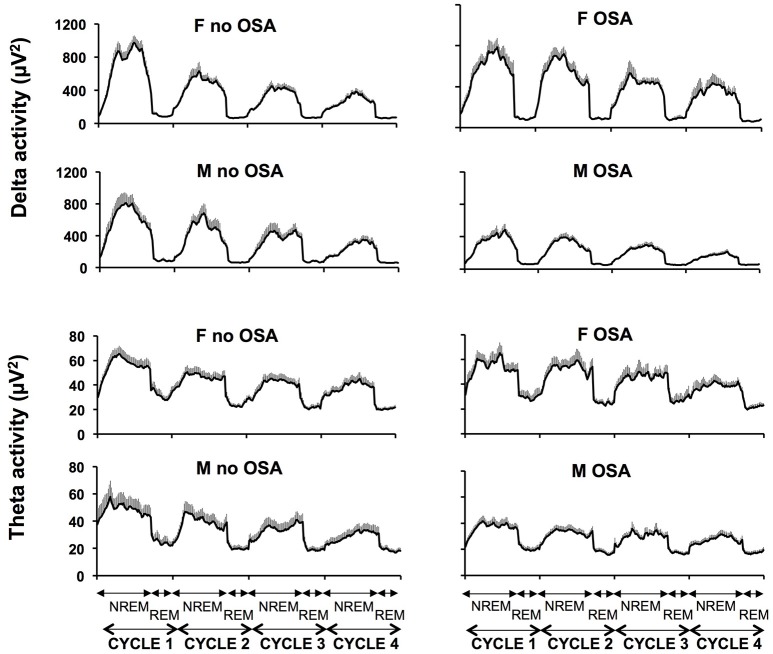
Unadjusted mean profiles (+SEM) of absolute SWA (4 upper panels) and theta activity (4 lower panels) during the first four NREM-REM cycles in women without and with OSA (upper panels) and men without and with OSA (lower panels). SWA slow wave activity; NREM non rapid eye movement sleep; REM rapid eye movement sleep.